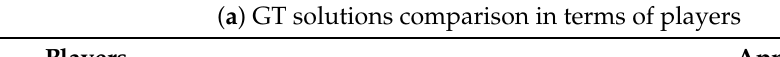
Table 3. GT solutions classification